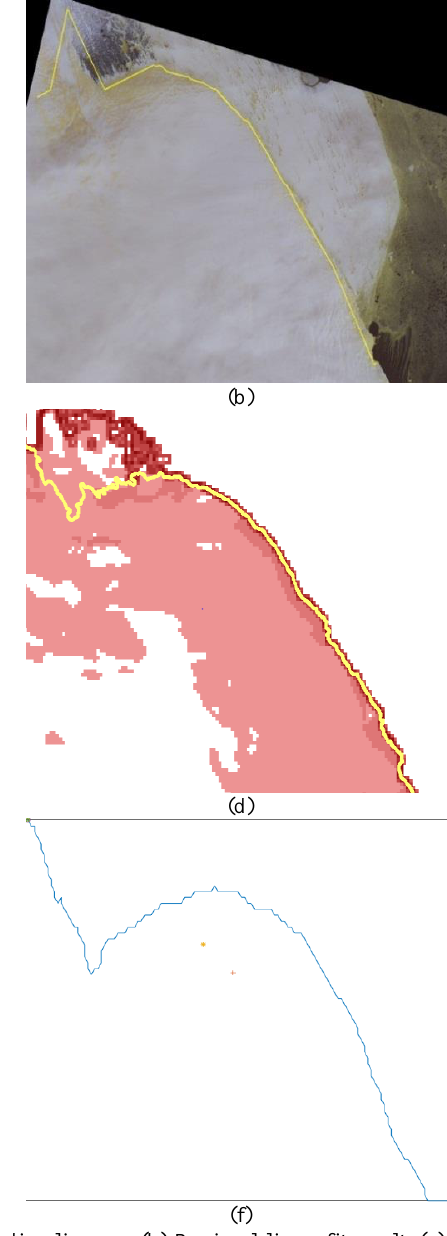
Fig.5. (a) Landsat8 standard deviation median filter of the initial grounding line area;(b) Regional linear fit results.(c) Croysat-2 elevation slope analysis, the red line is the location of the slope break;(d) The result of Croysat-2 extraction(the red line) and the existing Moa product(the yellow line); (e) Comparison of the fusion result (red) with the MOA product (yellow) on the image;